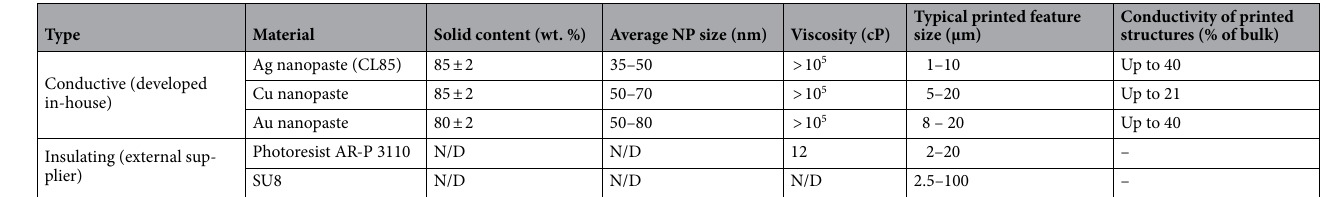
Table 1. A list of example conductive and non-conductive materials printed using the UPD technique and considered in this work. Viscosity is measured at 25 °C and shear rate = 0.2 s –1 . Photoresist AR-P 3110 was ordered from Allresist GmbH, whereas SU8 was ordered from